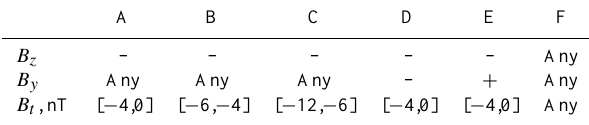
Table 1. IMF parameter limits selected for producing SuperDARN- based monthly convection maps. The third row shows the low and high limits of the B − t bins